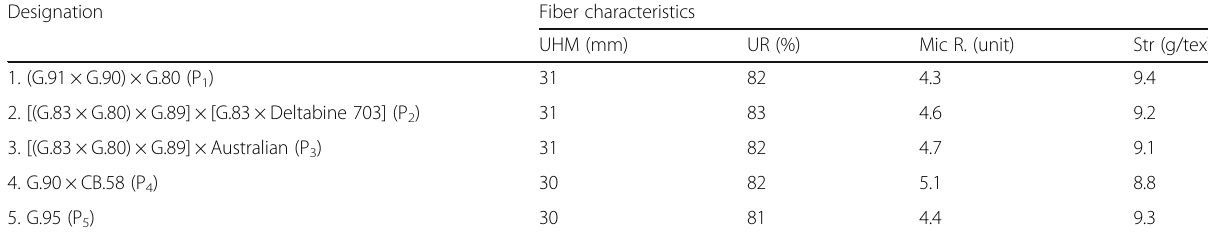
Table 1 Designation and main characteristics of five Egyptian cotton genotypes